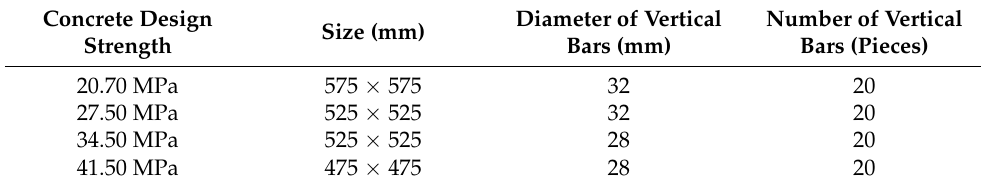
Table 9. Seven-story building column reinforcement detail.